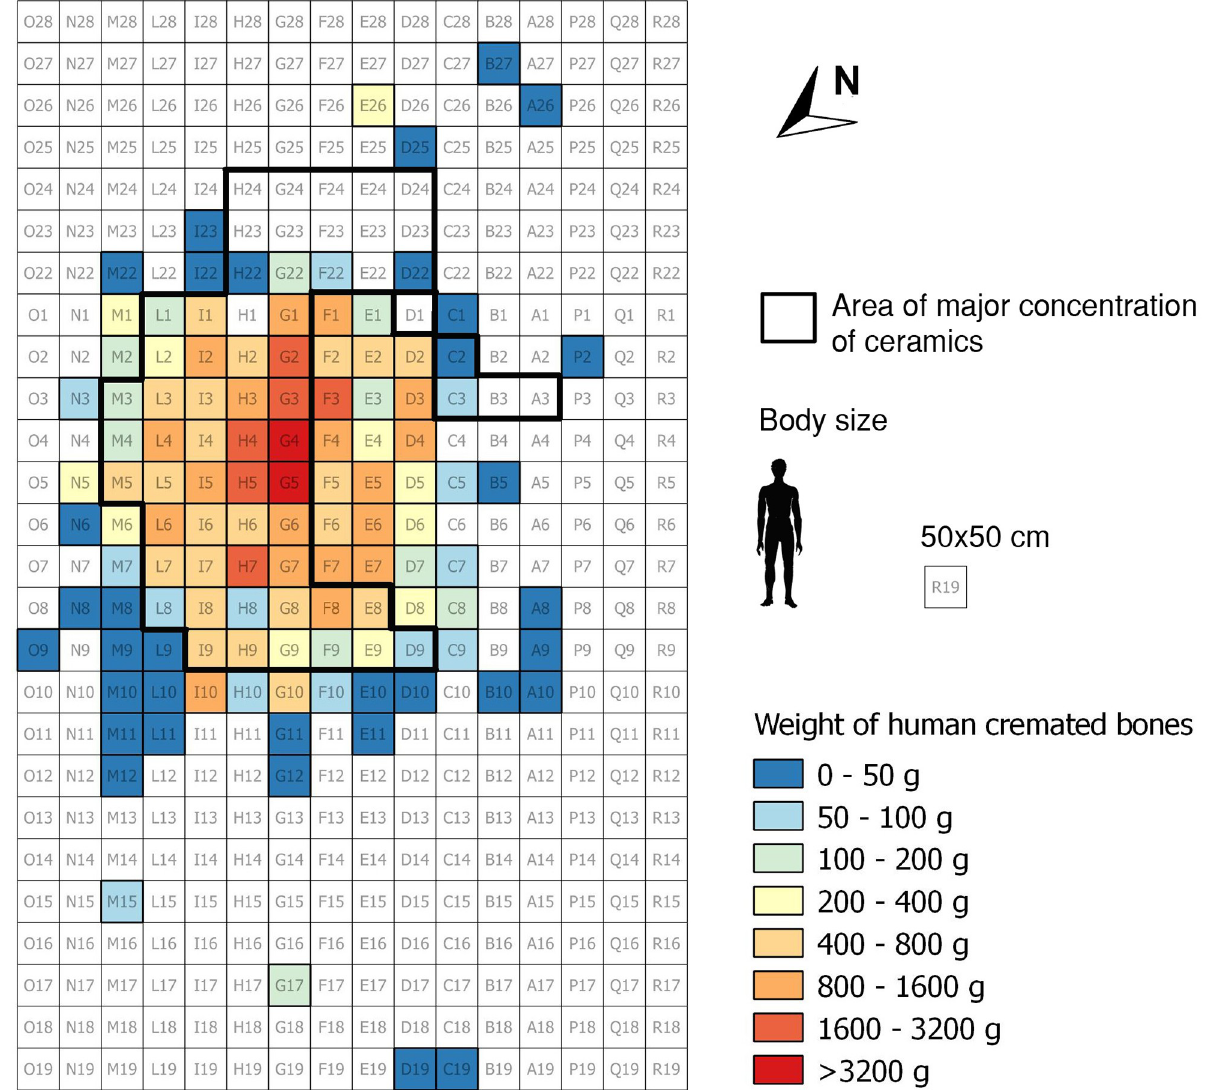
Fig 6. Distribution of bone fragments on the excavated area of 25x25 cm